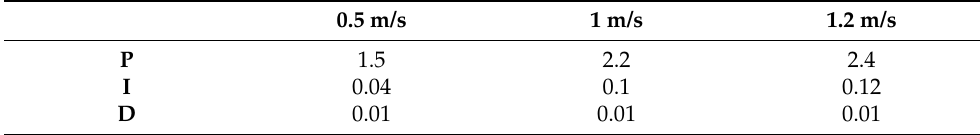
Table 3. The PID parameters of flight tests.